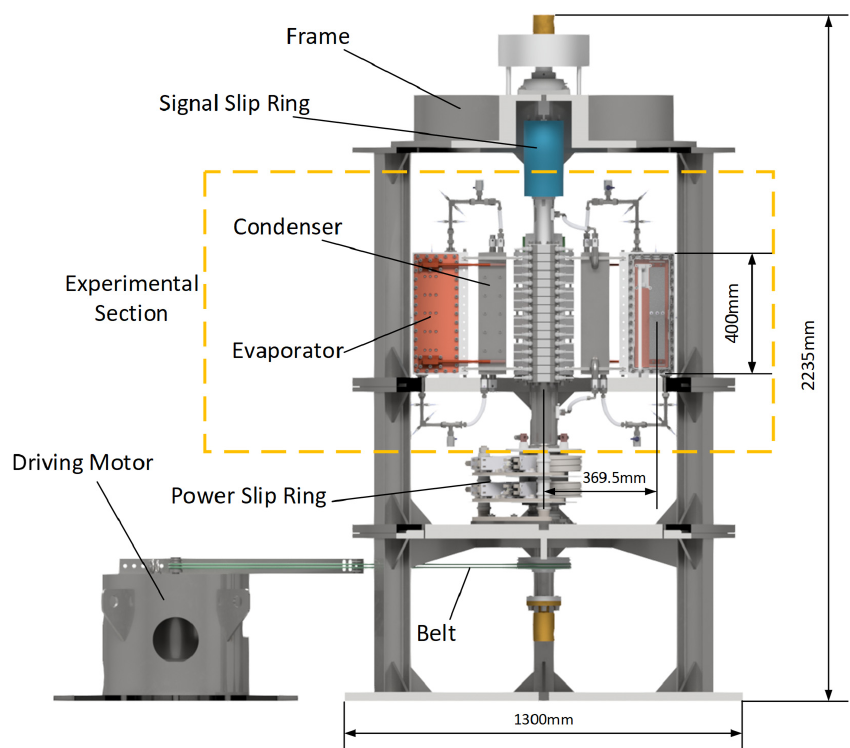
Figure 3. The Schematic of experimental device.